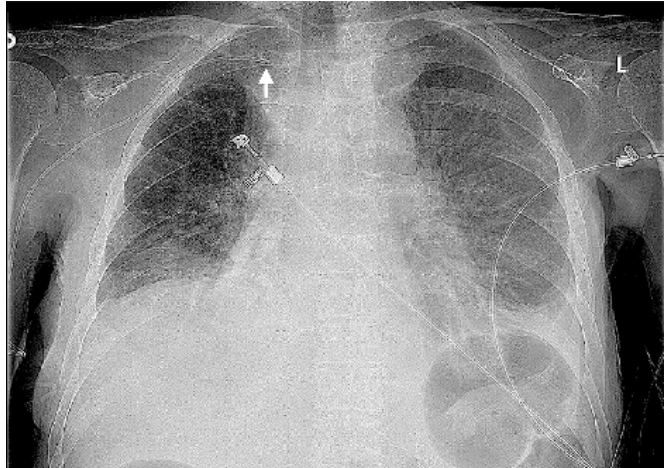
Image 1. Radiograph identifying migrated, right-sided peripherally inserted central catheter with tip in proximal right subclavian vein (arrow) with bilateral pleural